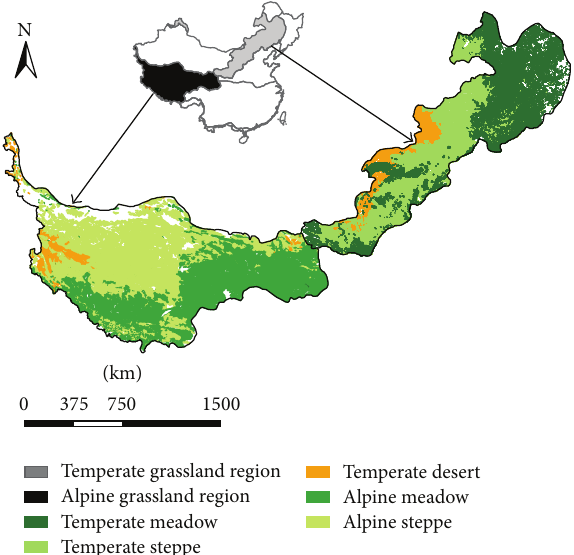
Figure 1: Spatial distribution of grasslands in temperate and alpine grassland regions of China, based on the vegetation and vegetation regionalizationmapsofChina(ChineseAcademyofSciences,2001), and two periods of land use maps of China in 1980s and 2005 (Chinese Academy of Sciences,